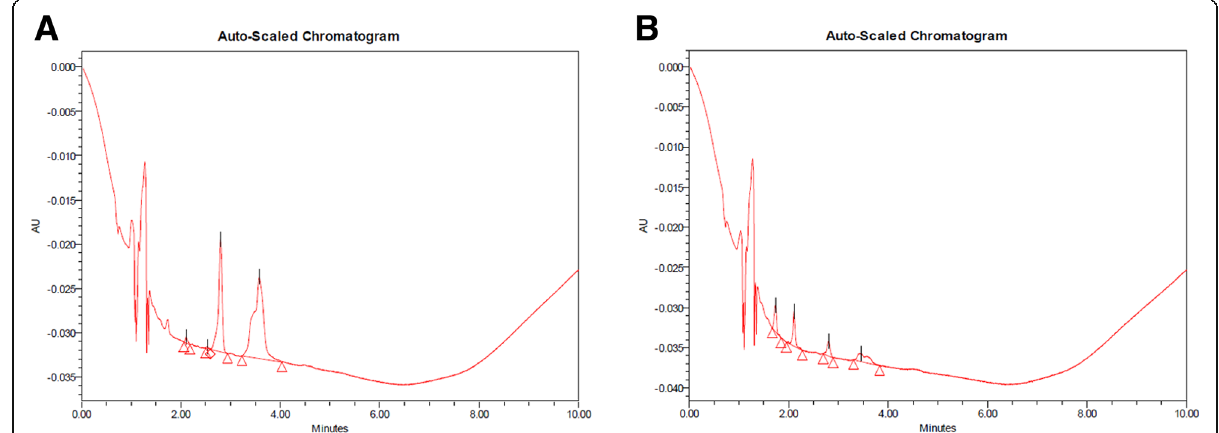
Fig. 1 UPLC chromatograms for P. edulis ( a ) and for P. guajava ( b ). Peaks were obtained using a C18